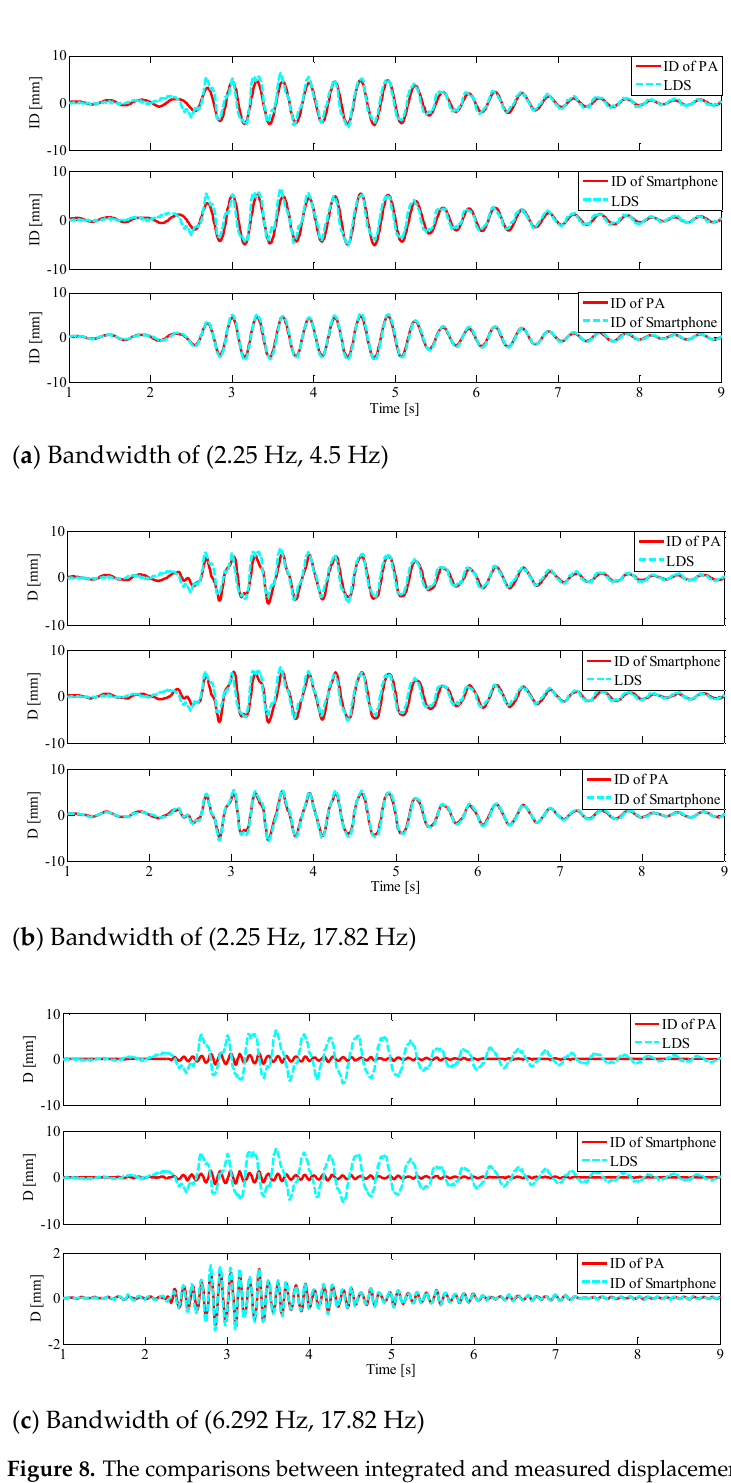
Figure 8. The comparisons between integrated and measured displacements of the first story (using data from PAs, LDS, and smartphones) for the undamaged case are